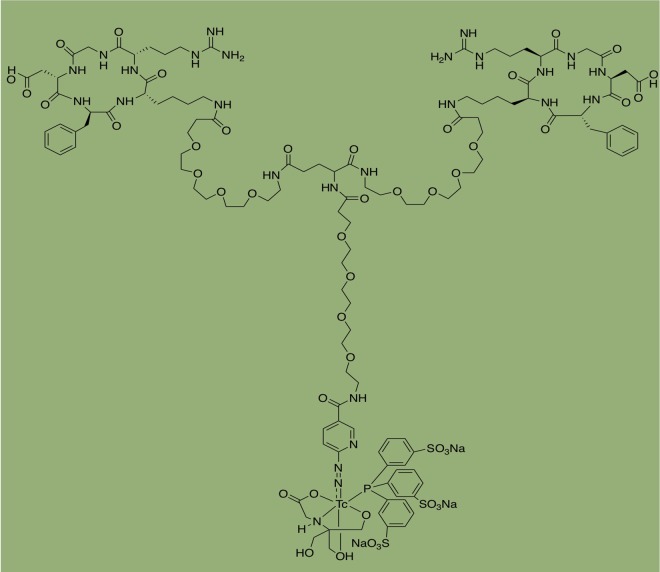
Structure of [99mTc]3PRGD2.